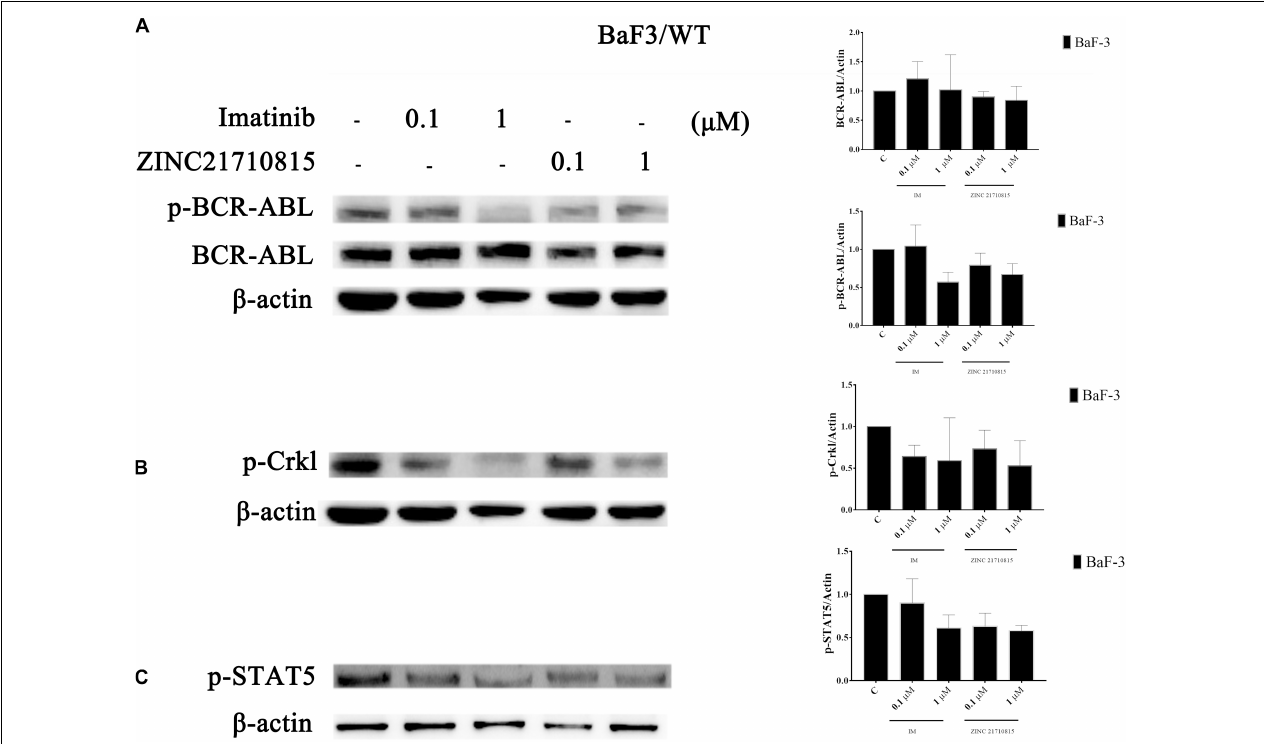
FIGURE 11 | BaF3/WT leukemia cells were incubated with 0 (vehicle), 0.1, or 1 µ M for 48 h with either imatinib and ZINC21710815 the levels of BCR-ABL and phosphorylated BCR-ABL (A) , and the downstream proteins p-Crkl (B) , p-STAT5 (C) were analyzed using western blotting. The results are represented as the mean ±